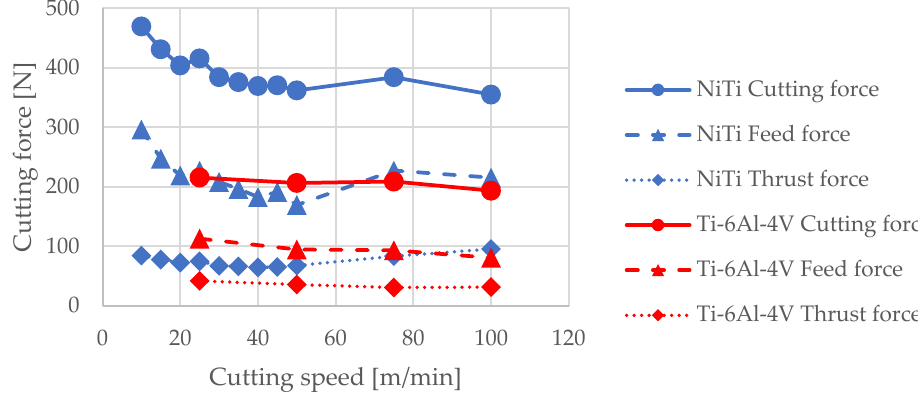
Figure 4. Relationship between the cutting speed and force.